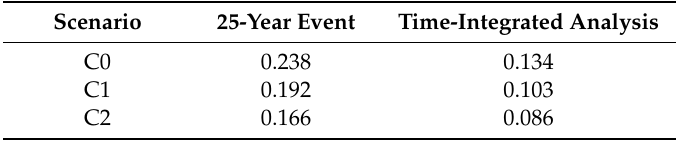
Table 4. Global index for the Canal do Mangue catchment.